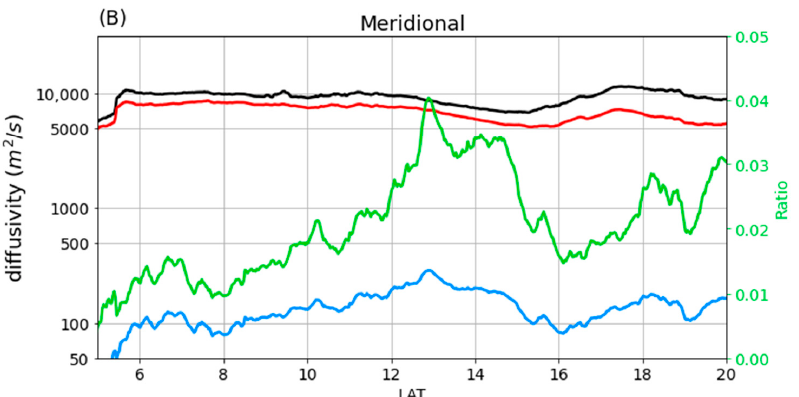
Figure 12. Absolute diffusivity (black line), relative diffusivity (red line), and coherent relative diffusivity (blue line) in ( A ) zonal and ( B ) meridional directions over 30 days, with the green line indicating the ratio of coherent relative diffusivity to the relative diffusivity. Note the non-uniform scale on the y axis.